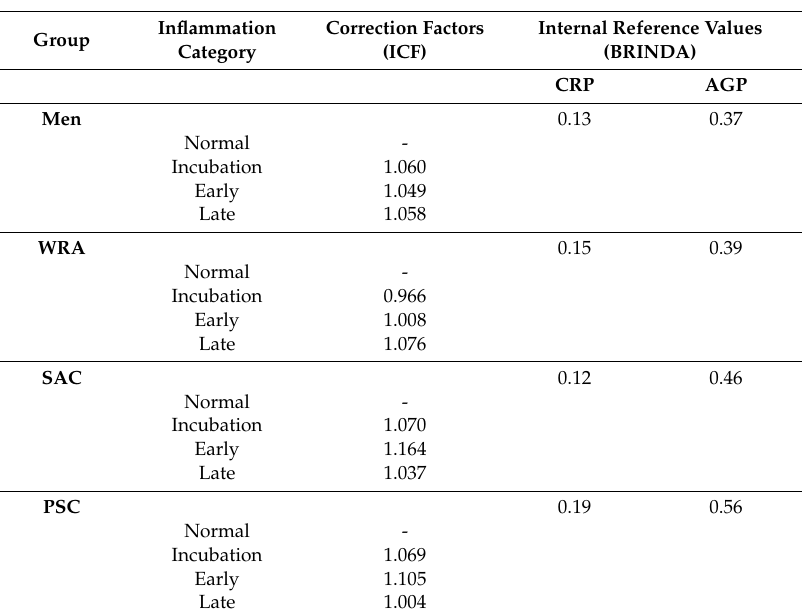
Table 3. Internal correction values for ICF and BRINDA that were used to adjust SZC values for inflammation.